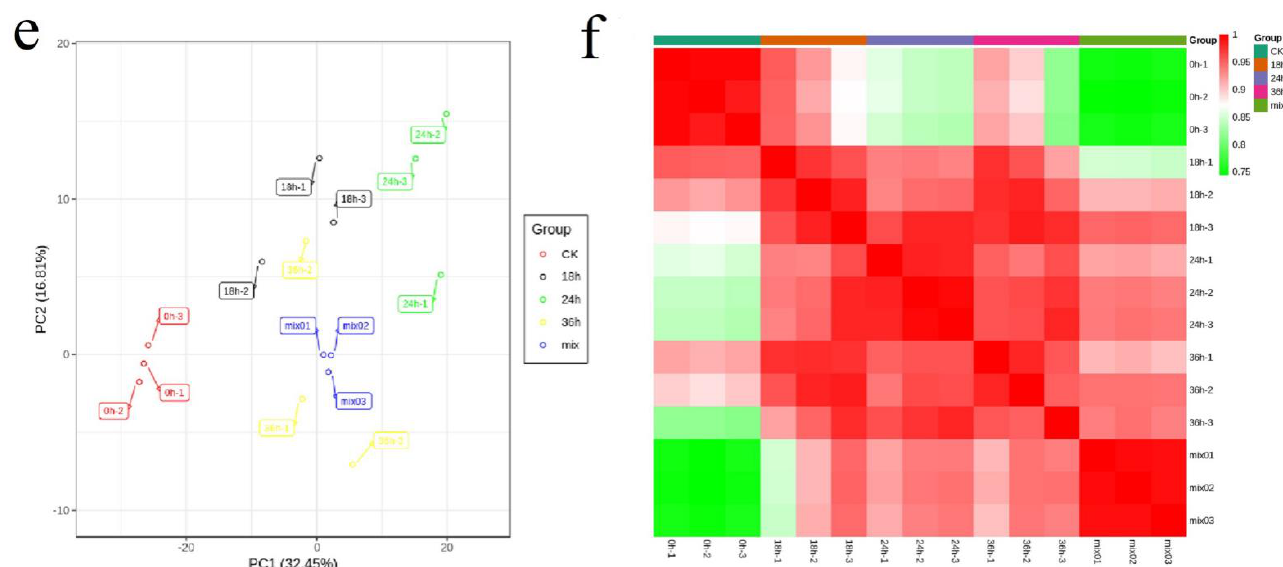
Figure 2. The morphology of Jerusalem Artichokes treated with drought stress, and the heatmap of correlation and principal component analysis (PCA) between different drought treatment and quality control (QC) samples. ( a ) 0 h; ( b ) 18 h; ( c ) 24 h; ( d ) 36 h; ( e ) Principal component analysis. ( f ) Heatmap of correlation.